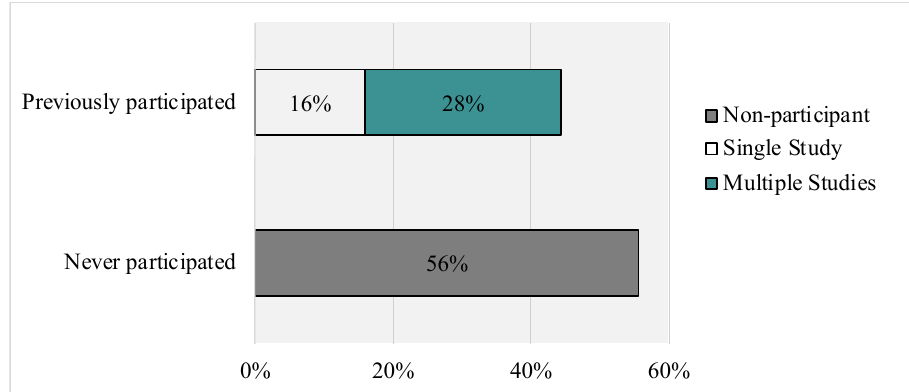
Figure 3. Prior Research Participation.